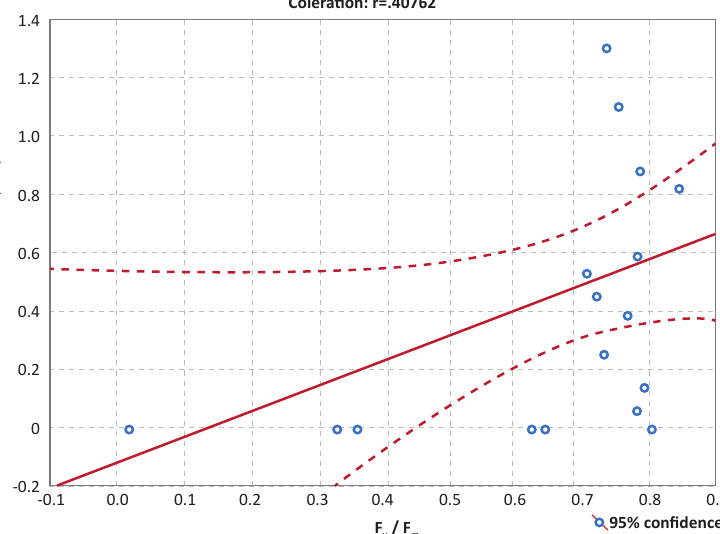
FiGure 2. Correlations between diameter increment (mm) of container seedlings of narrow-leaved ash and the maximum quantum yield of photosystem II (F /F ) in normally watered seedlings on 16 July 2015 v m